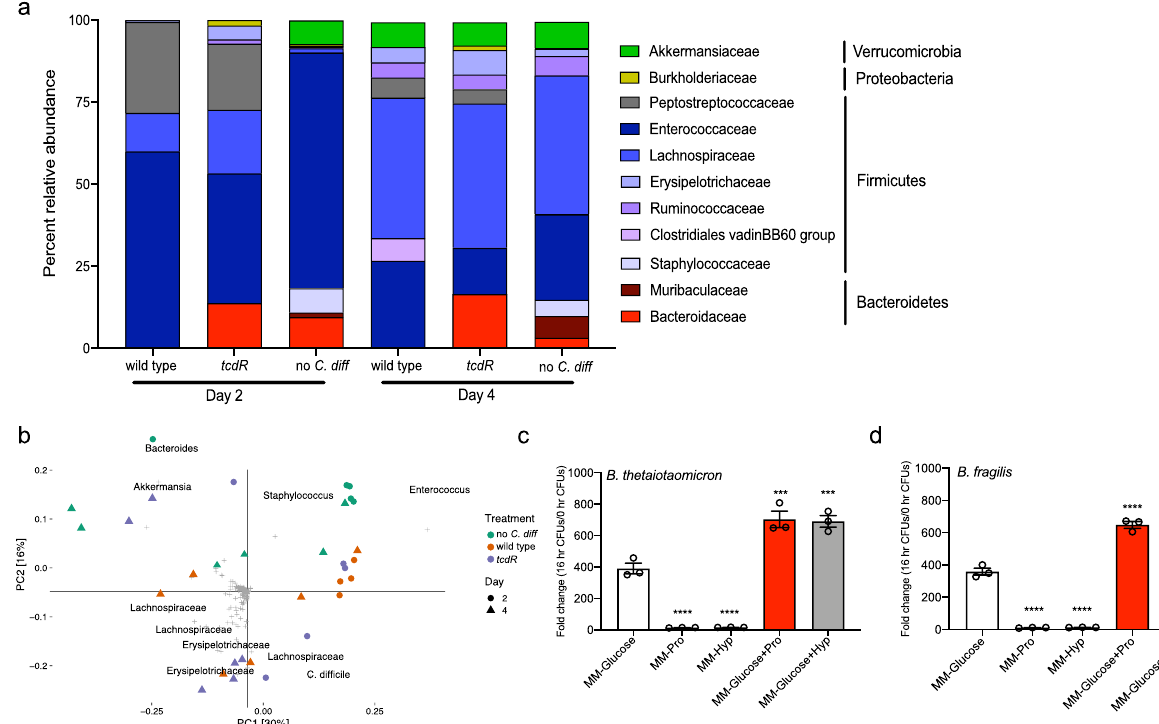
Fig. 5 C. dif fi cile toxin activity suppresses the Bacteroidaceae that are able to compete with C. dif fi cile for amino acids. a Averaged percent relative abundance of Family level ASVs in each treatment group per timepoint. ASVs with less than 1% relative abundance in all samples were not included. b PCA biplot of 16S rRNA amplicon sequences derived from cecal tissue from uninfected or no C. diff control mice ( n = 5 on day 2, n = 6 on day 4), wild type mice ( n = 4 on day 2, n = 6 on day 4) and tcdR mice ( n = 5 on day 2, n = 6 on day 4). Each colored symbol represents an individual mouse ’ s cecal microbiome, with circles being those from day 2 and triangles from day 4. 99% of OTUs are shown as gray crosses; the 10 OTUs furthest from the origin are labeled by the fi nest taxonomic rank identi fi ed (family, genus, or species). c 16 h fold change in CFUs of B. thetaiotaomicron in minimal media with ( n = 3) or without glucose ( n = 3), supplemented with either proline ( n = 3) or hydroxyproline ( n = 3) **** p = 0.0003, MM-Glucose vs. MM-Glucose + Pro; MM-Glucose vs. MM-Glucose + Pro, *** p = 0.0005; **** p < 0.0001. d 16 h fold change in CFUs of B. fragilis in identical media conditions as in ( c ) ( n = 3 for each condition) **** p < 0.0001. All data in ( c ) and ( d ) are presented as the mean and error bars indicate the SEM. Statistical signi fi cance in ( c ) and ( d ) was determined by One-way ANOVA with Tukey ’ s multiple comparisons